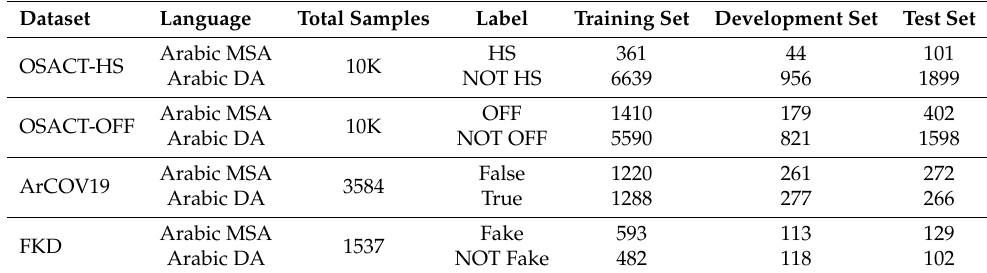
Table 2. Descriptions and statistics for OSACT, ArCOV19, and FKD datasets.